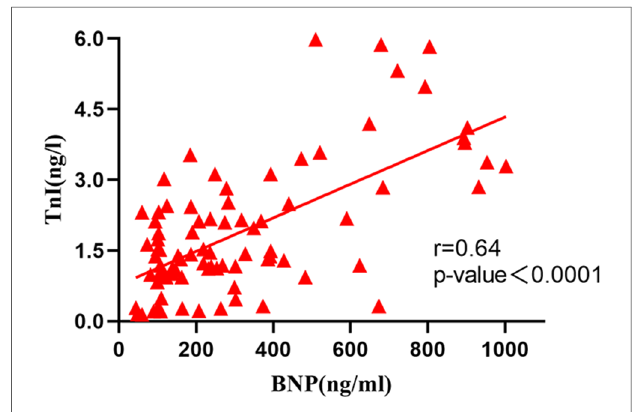
FIGURE 6 Correlation between serum BNP and TnI after